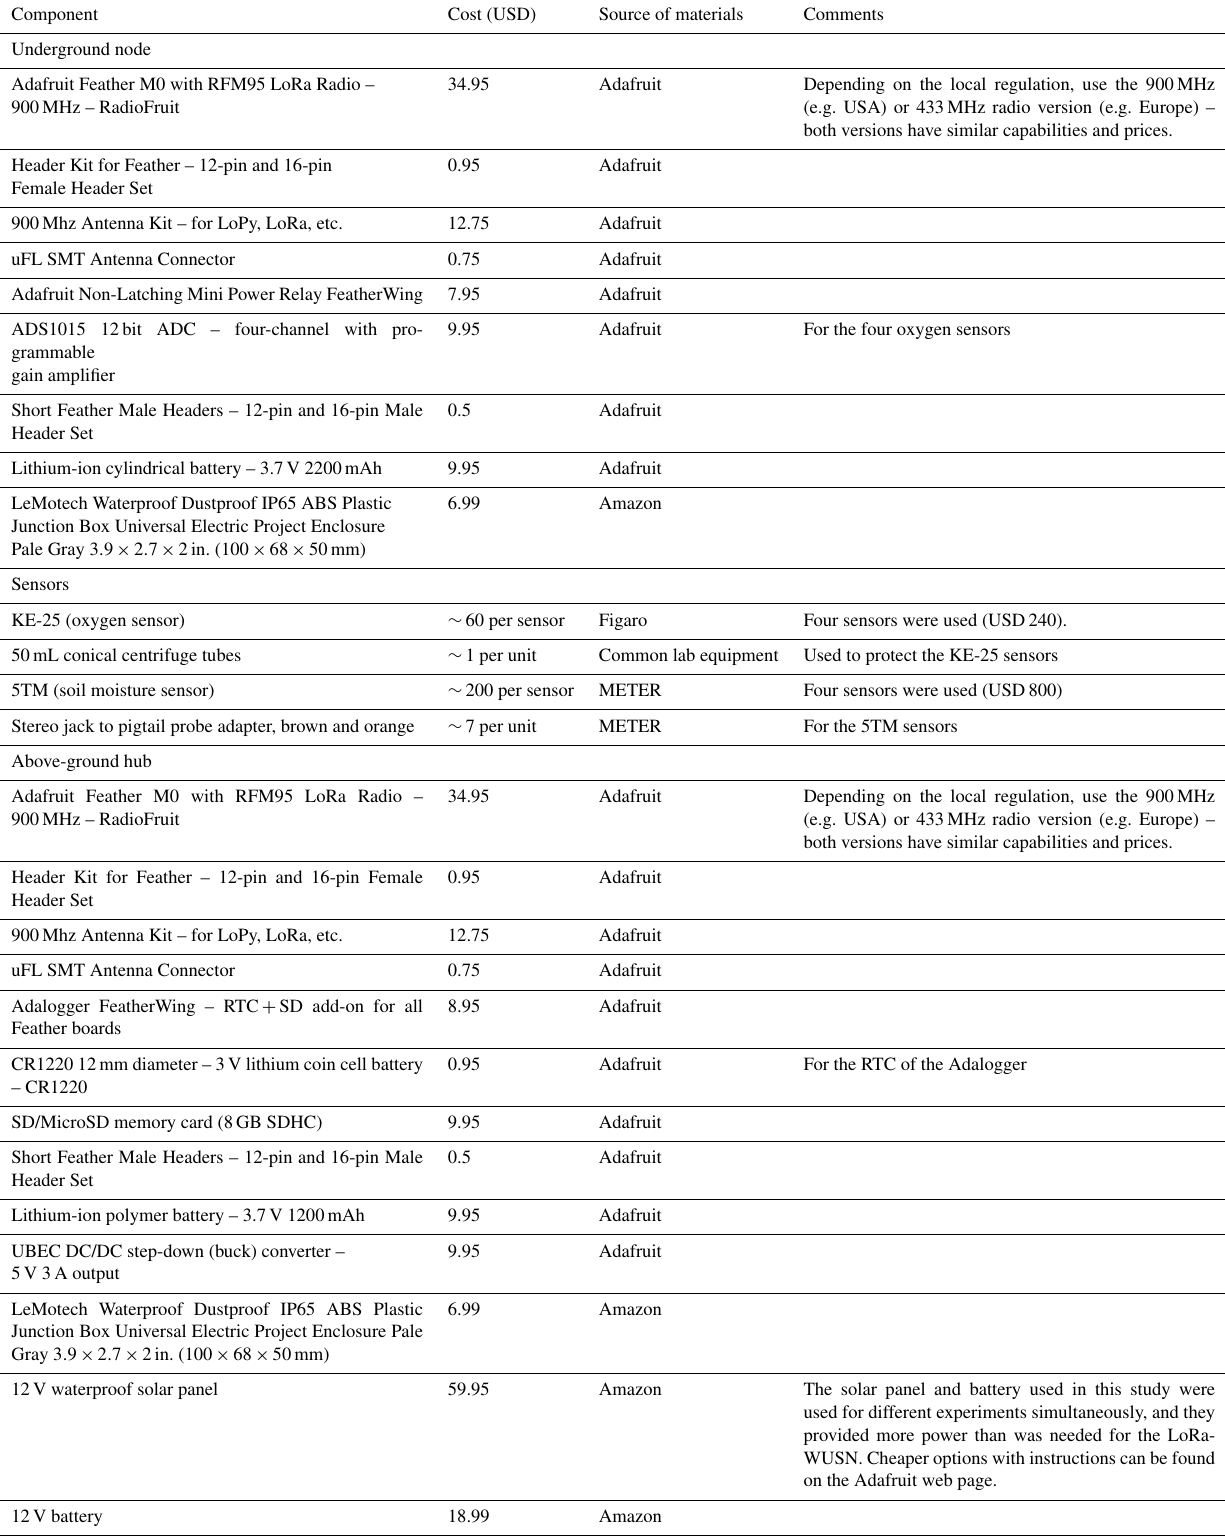
Table 1. Summary of hardware components and materials used in this study. Component Cost (USD) Source of materials Comments Underground node